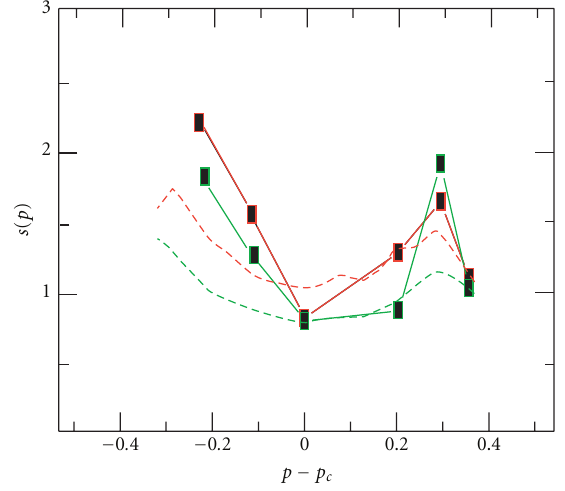
Figure 6: Slope versus metal concentration for numerical (dashed line) and experimental (solid line and square symbols) data. The wavelengths of the incident light are λ = 543nm (green color) and λ = 633nm (red color) [24, Figure